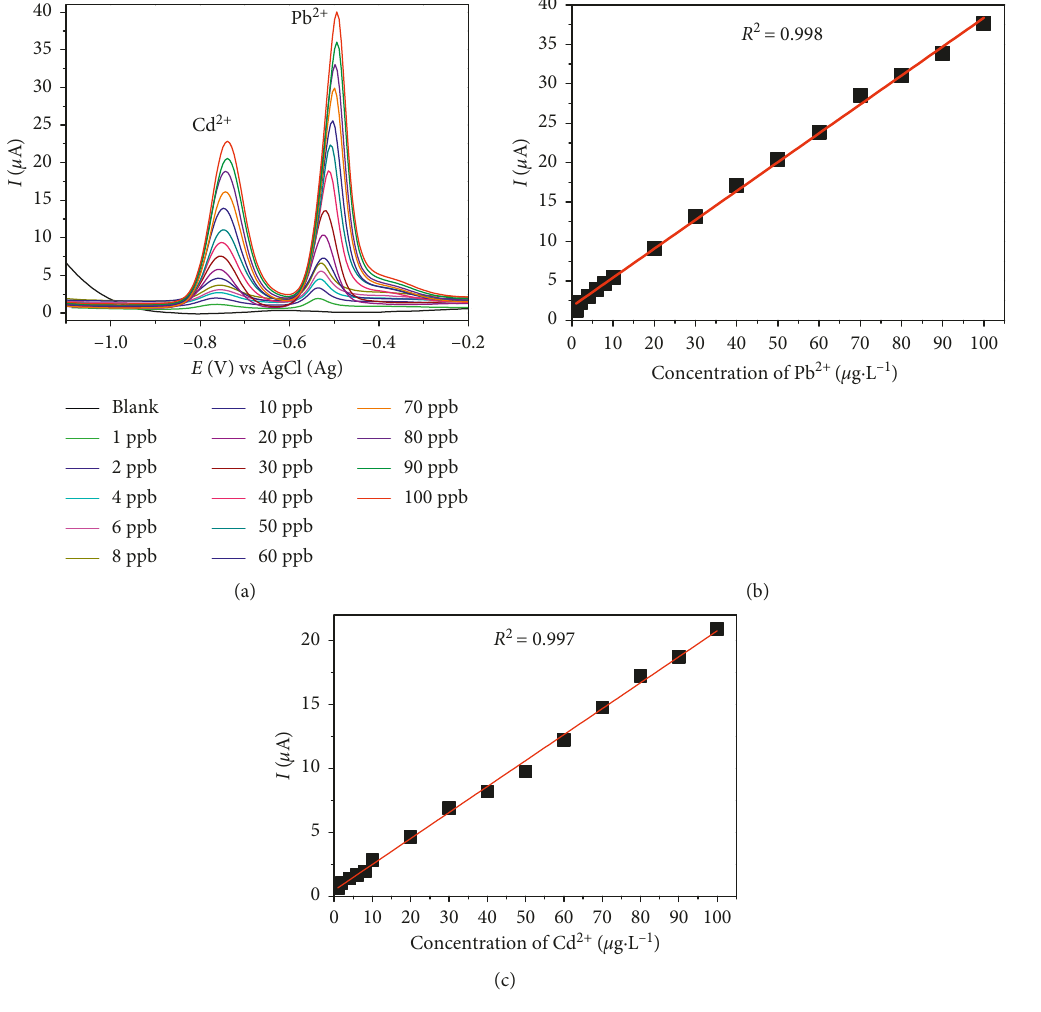
Figure 9: DPASVs at different concentrations of Pb 2+ and Cd 2+ ions at the PtNFs/GCE (a) and relationship between Pb 2+ and Cd 2+ concentrations with corresponding peak currents (b, c).